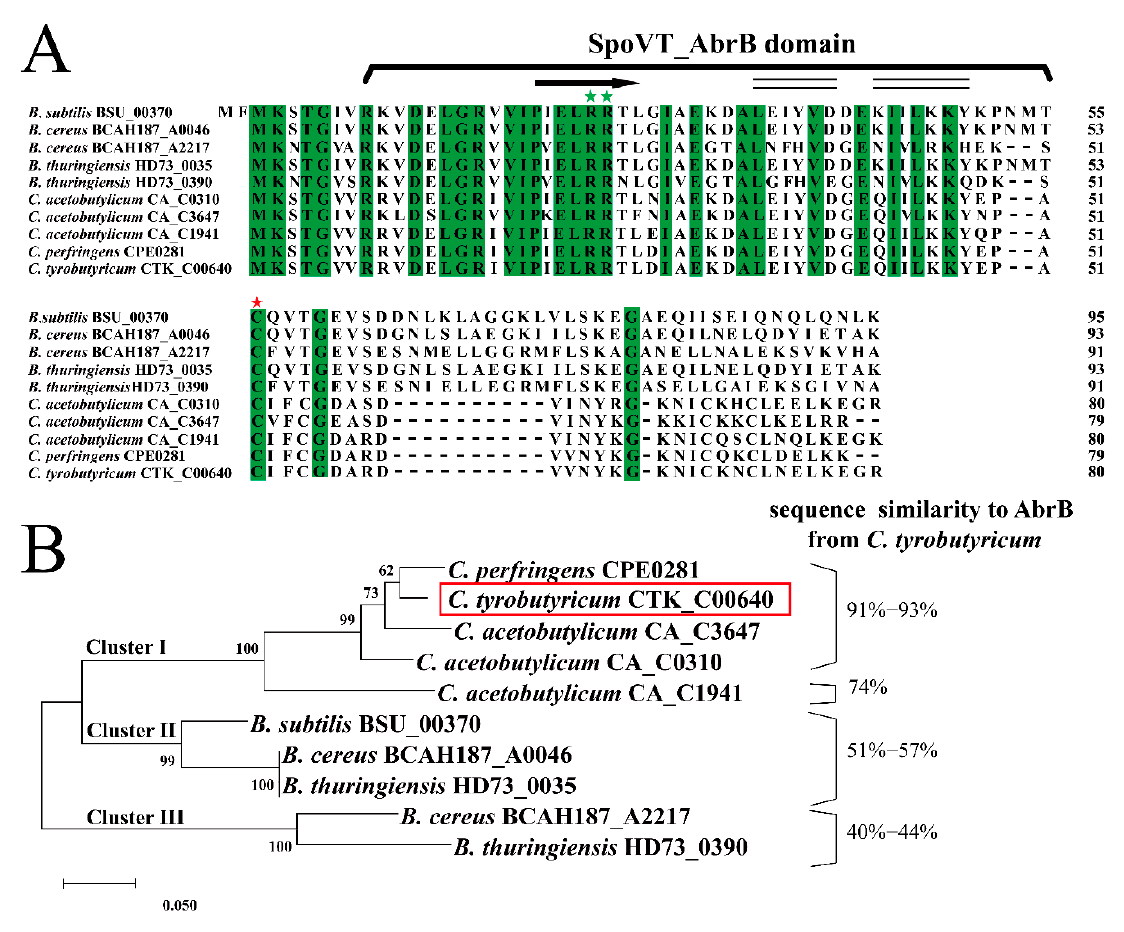
Figure 1. Identification and analysis of AbrB in C. tyrobutyricum ATCC 25755. ( A ) Amino acid sequence alignment of AbrB (CTK_RS00405) in C. tyrobutyricum ATCC 25755 with the AbrB homologs from other selected strains. The residues predicted to encode the SpoVT-AbrB domain are identified, and the identical residues are highlighted in green. The conserved cysteine acid residue responsible for AbrB polymerization and DNA binding activity is marked with red stars and the conserved arginine residues for DNA binding are marked with green stars. Secondary structure of AbrB was predicted according to NMRPROCHECK and NOEs ( α -helix, black double-line; β -sheet, black arrows). ( B ) Maximum-likelihood protein similarity tree based on amino acid sequences of AbrB from C. tyrobutyricum ATCC 25755 and selected homologs of other spore-forming Gram-positive strains. The phylogenetic tree was constructed by MEGA-X based on the distance method with Neighbor-Joining (NJ) with 1000 bootstrap replicates. The AbrB of C. tyrobutyricum is enclosed in red box.